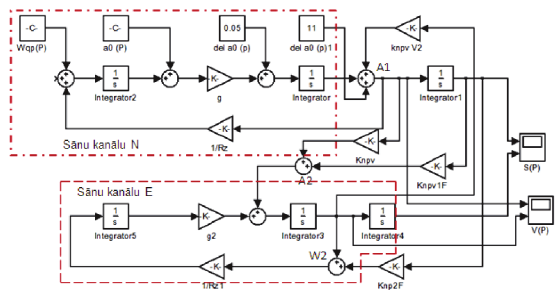
Fig. 6. Мodel of inertial system errors when two channels jointly